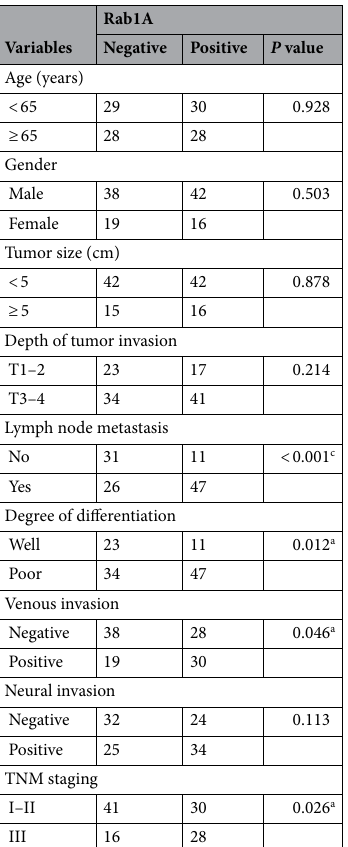
Table 1. Relationship between Rab1A and clinic-pathological factors in 115 GC patients. a P < 0.05, b P < 0.01, c P < 0.001.